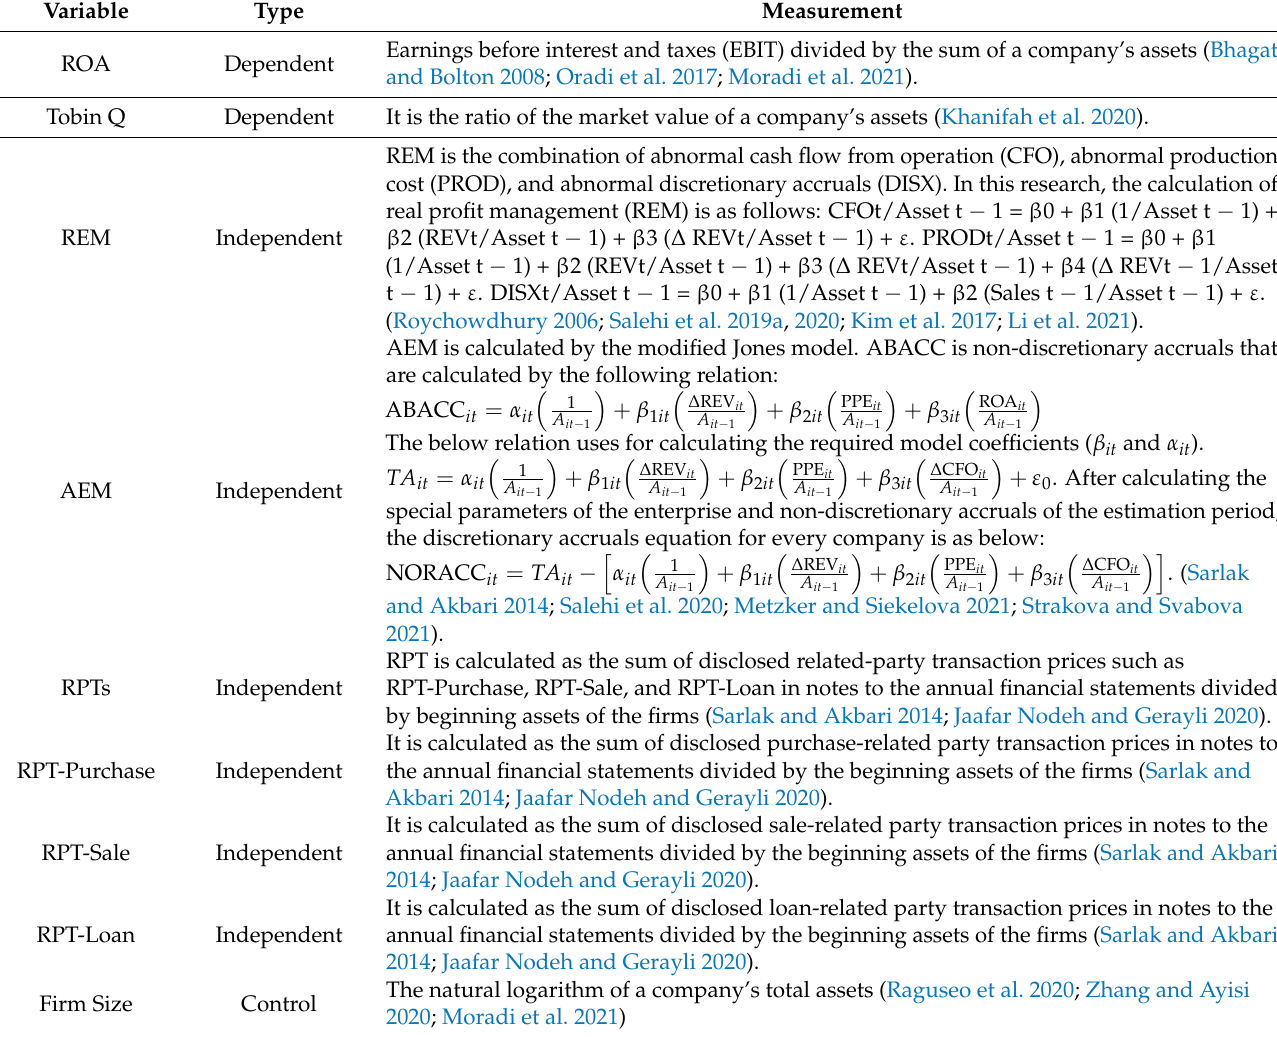
Table 2. Definition of the